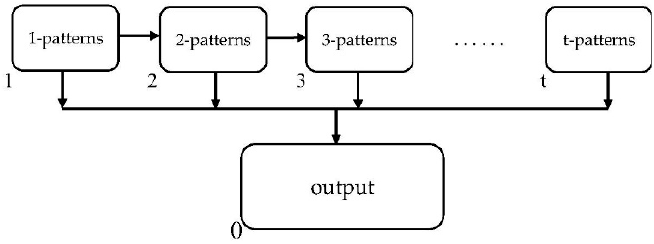
Figure 2. The tissue-like P system for the ETPAM algorithm.